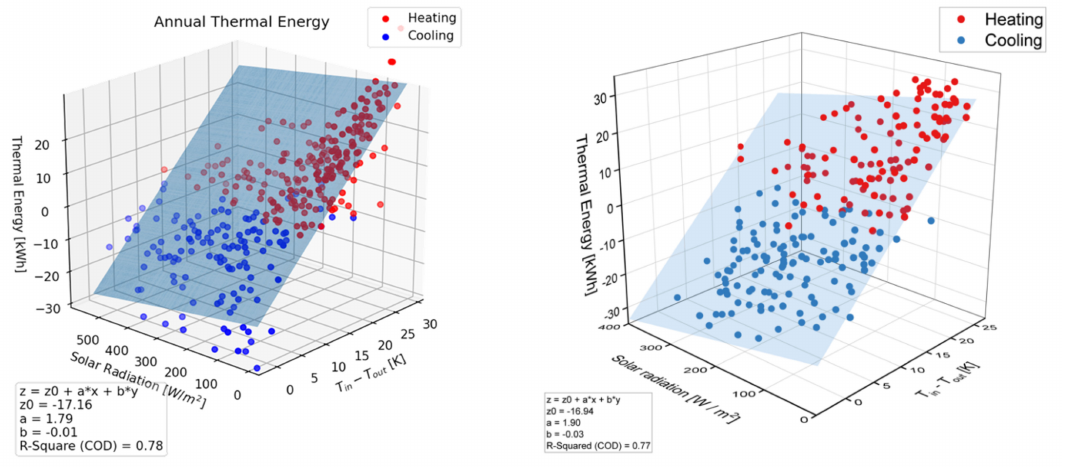
Figure 10. Daily heating and cooling demands as a function of average daily temperature difference for simulated ( left ) and monitored data ( right ).